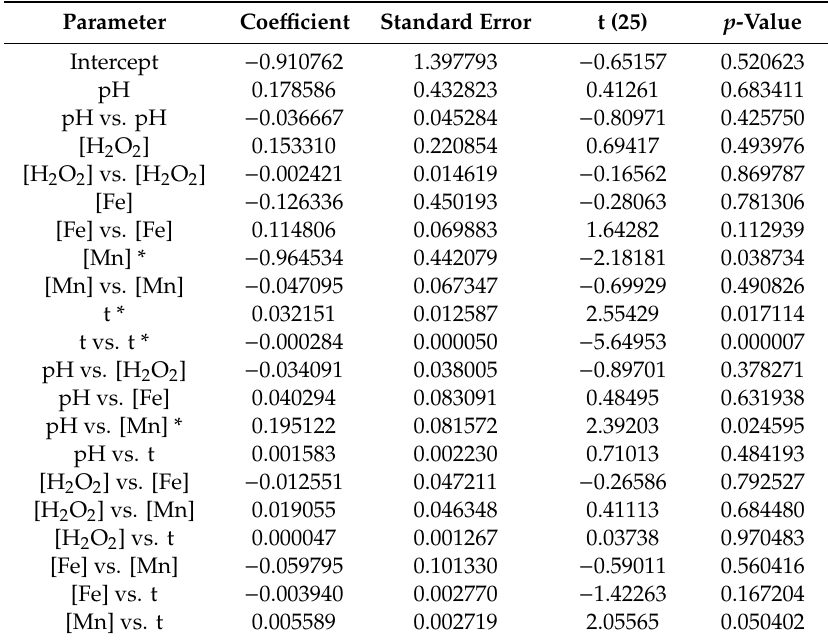
Table 4. Coe ffi cients of regression from the quadratic model for e ffi ciency of TMP degradation treated by the Fenton-like